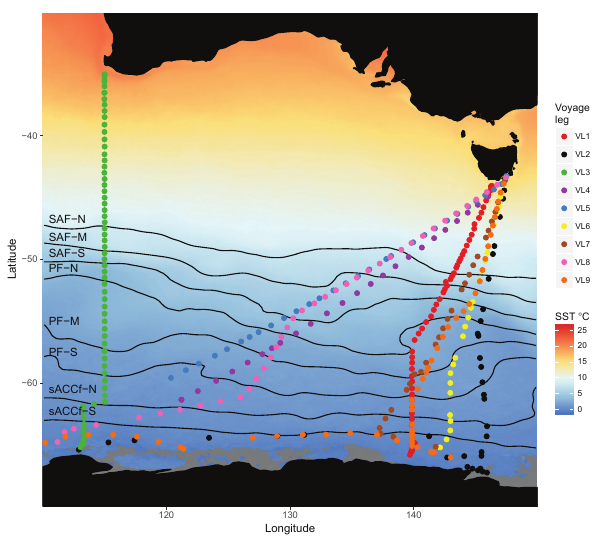
Figure 1. Map of sample sites (dots) relative to major South- ern Ocean fronts (lines) and satellite SST (means for productive months, October–March, over the sample collection period 2008– 2014). Front abbreviations: SAF – Subantartic Front; PF: Polar Front; sACCf: Southern Antarctic Circumpolar Current Front; N: north; M: middle; S: